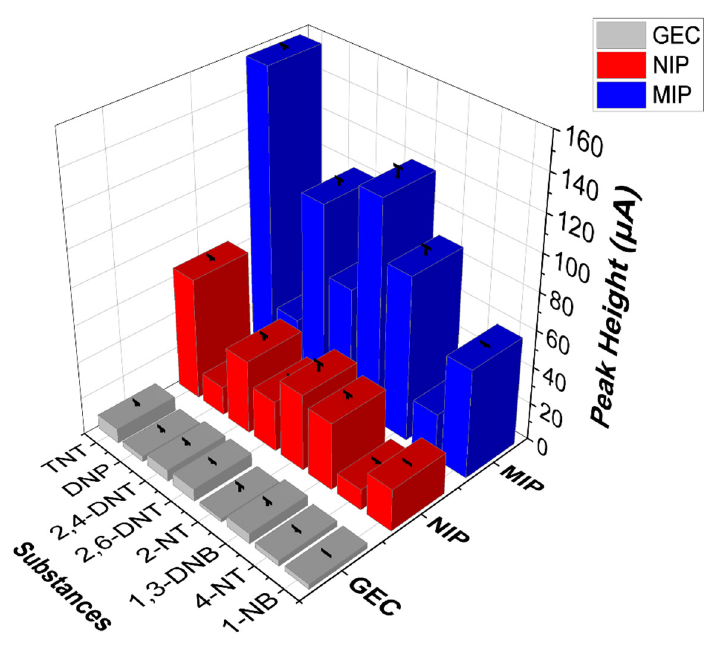
Figure 7. Comparison of voltammetric response of 10 µmol L − 1 nitroaromatic compounds for each sensor and different nitroaromatic species.